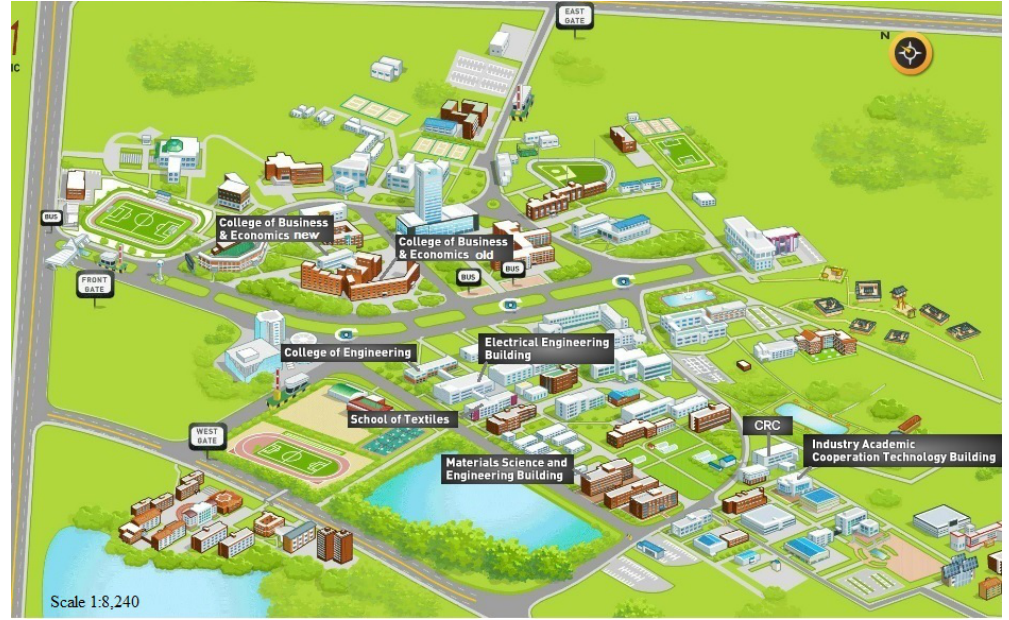
Figure 8. Buildings for the experiment in Yuengnam